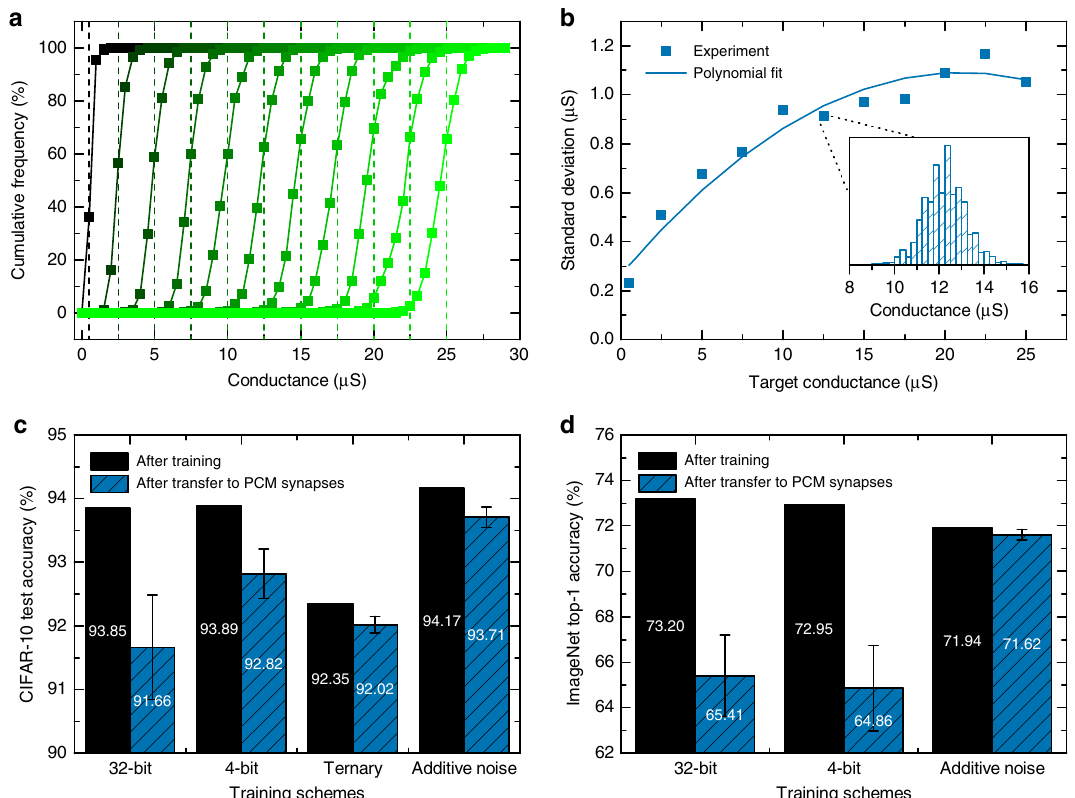
Fig. 3 Impact of weight transfer to PCM synapses on inference accuracy. a Cumulative distributions of 11 representative iteratively programmed conductance levels on 10,000 PCM devices per level. The vertical dashed lines denote the target conductance for each level. b Conductance standard deviation of the 11 levels as a function of target conductance. The inset shows a representative conductance distribution of one level. c Test accuracy on CIFAR-10 after software training and after weight transfer to PCM synapses for different training schemes. d Top-1 accuracy on ImageNet after software training and after weight transfer to PCM synapses for different training schemes. The weights of all layers of ResNet-34 are transferred to PCM synapses, including the fi rst and the last. In c and d the error bars represent the standard deviation over 10 inference